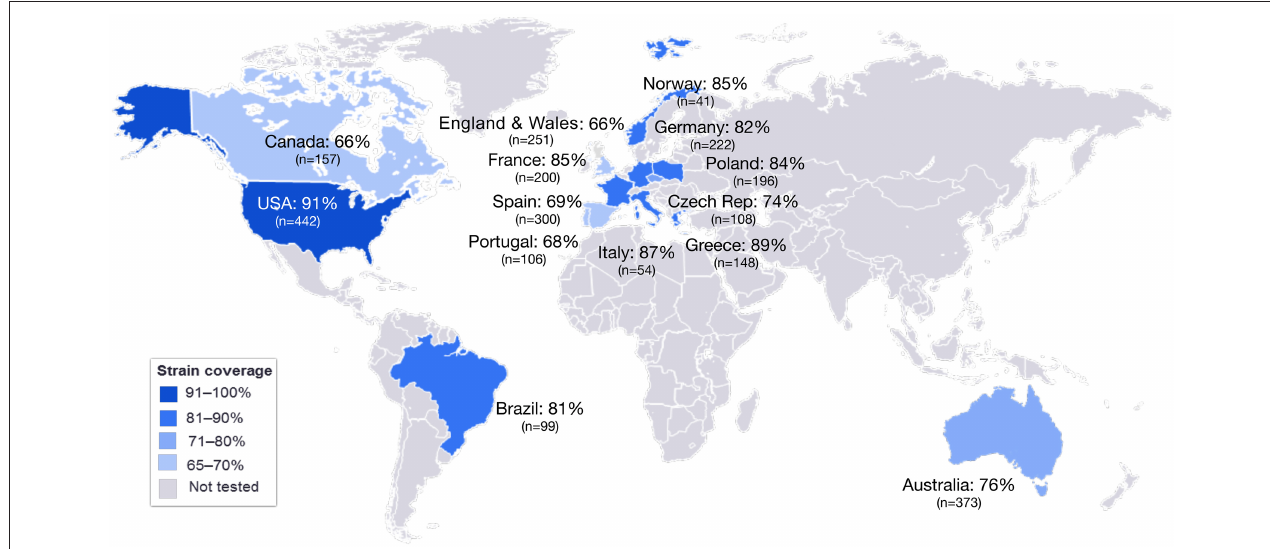
FIGURE 5 | MATS coverage estimates by geographic region. This map schematically represents the results of MATS coverage estimates generated on MenB isolates from different countries colored in blue and scaled according to coverage estimates. Countries for which MATS estimates are not available are colored in gray. In each box is shown the MATS prediction (%) of strain coverage for each country, along with the number ( n ) of strains